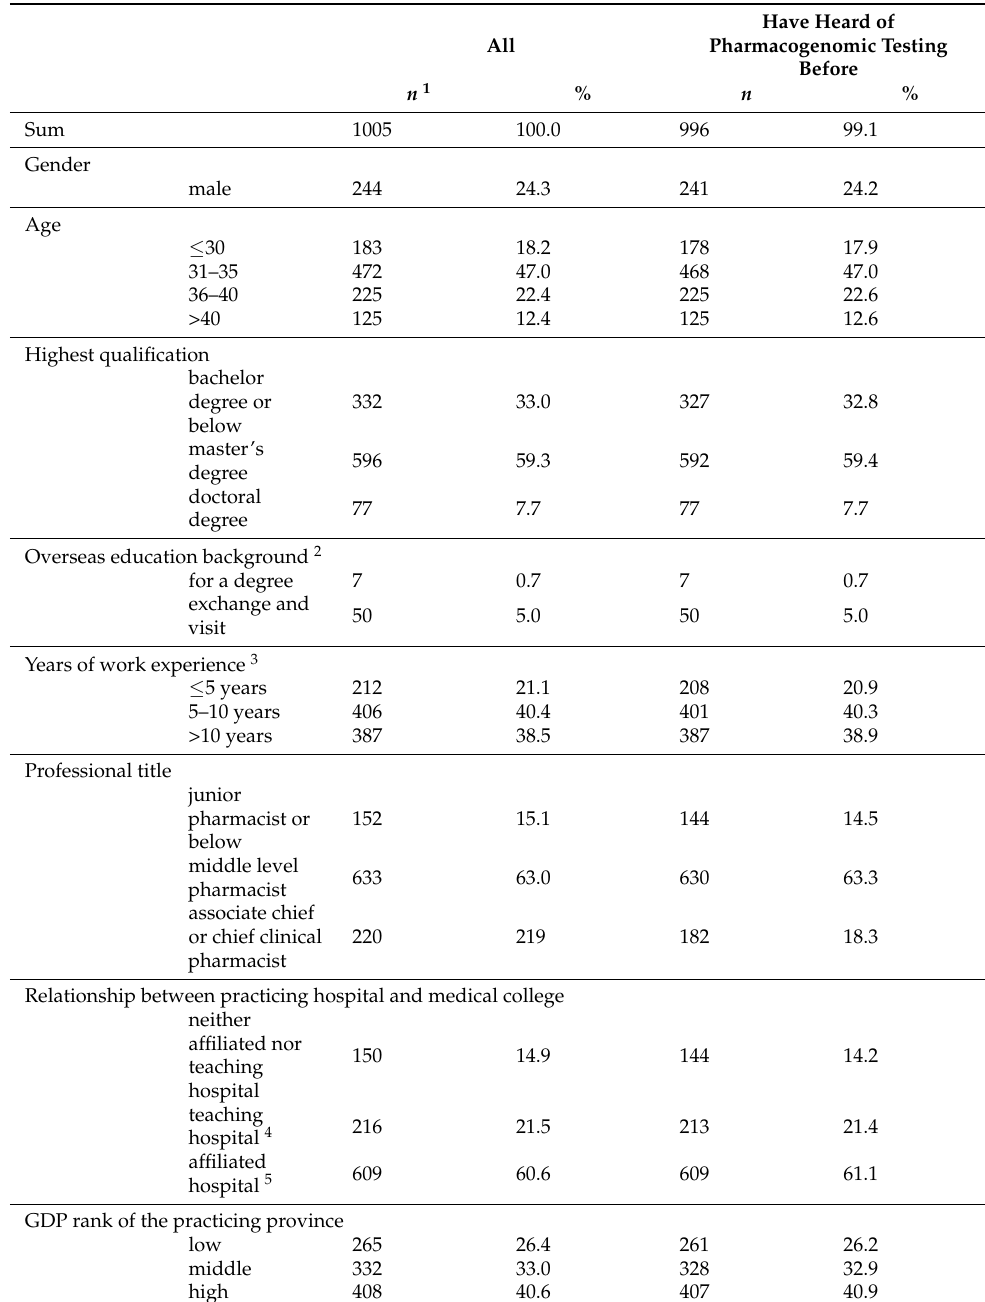
Table 1. Characteristics of study